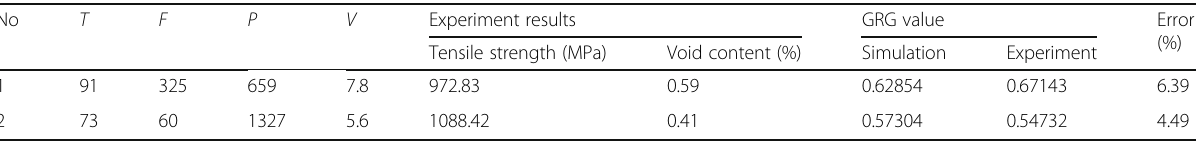
Table 4 Experimental verification of BP neural network model No T Experiment